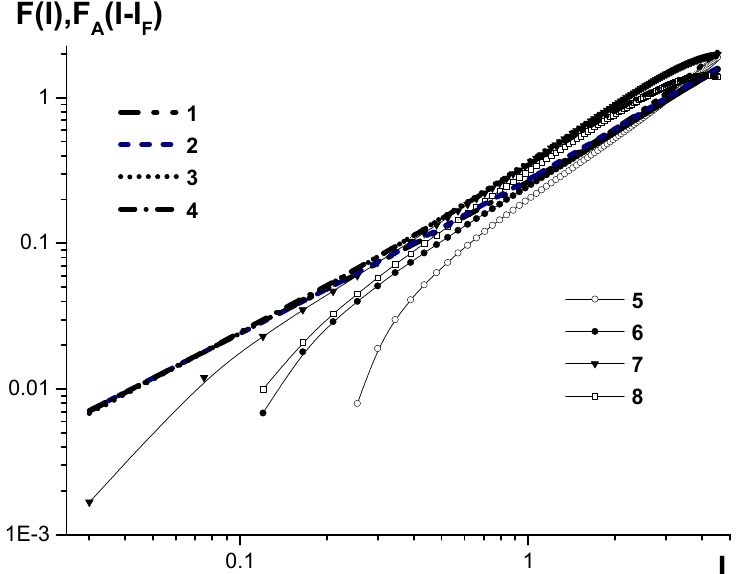
Figure 3. Calibration curves to determine carbon concentration in low- and medium-alloyed steels on SPAS-02 and SPAS-05 emission spectrometers. The curves are reduced to the same relative intensity range by multiplying by the coefficients k ; 1–4 are calibration curves F A ( I − I F ) , plotted by the developed algorithm with accurate accounting for plasma background, and 5–8 are plotted by the conventional algorithm for SPAS-05, serial number № 18, k = 0.38; SPAS-02, serial number № 22, k = 1.07; SPAS-02, serial number № 25, k = 1.37; SPAS-02, serial number № 26, k = 1, respectively. It can be seen that in the area of relative carbon content lower than 0.15–0.3%